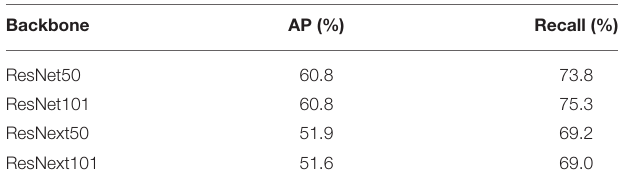
TABLE 2 | AP and Recall comparison with the other